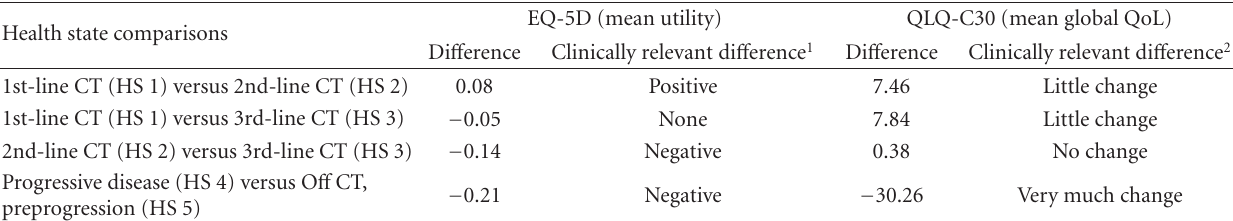
Table 6: Clinically relevant di ff erences between health states.